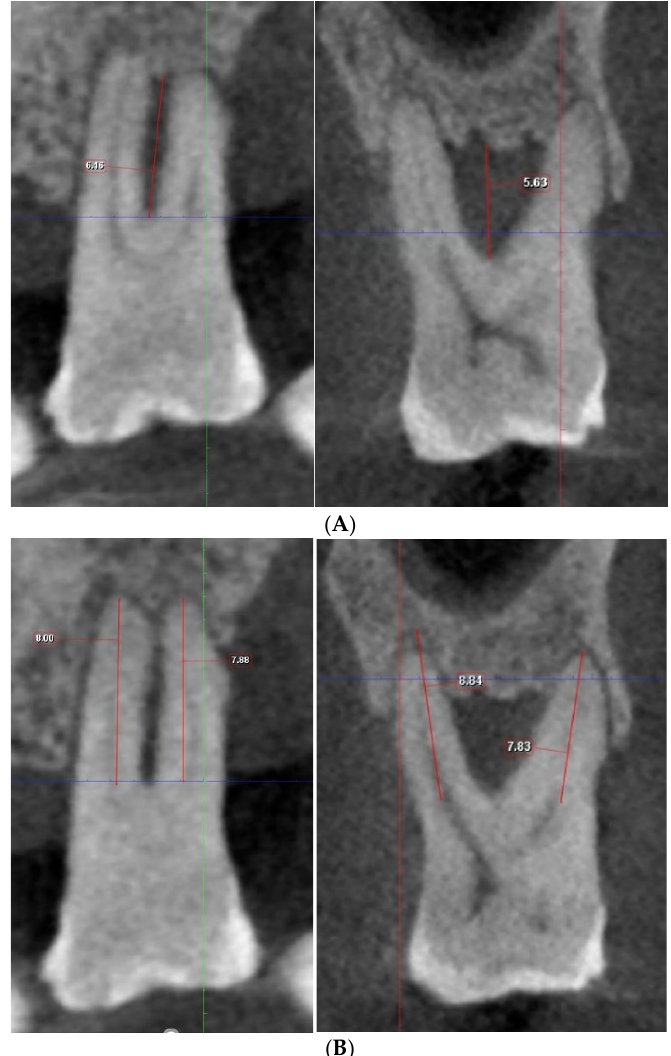
Figure 2. ( A ) Measurement of vertical depth of furcation and root length on Romexis (Planmeca). ( B ) By toggling the CBCT along the adjusted axis, the maximal vertical distance from the furcation fornix to the base of the defect and the length of the shorter root bounding the furcation were measured.